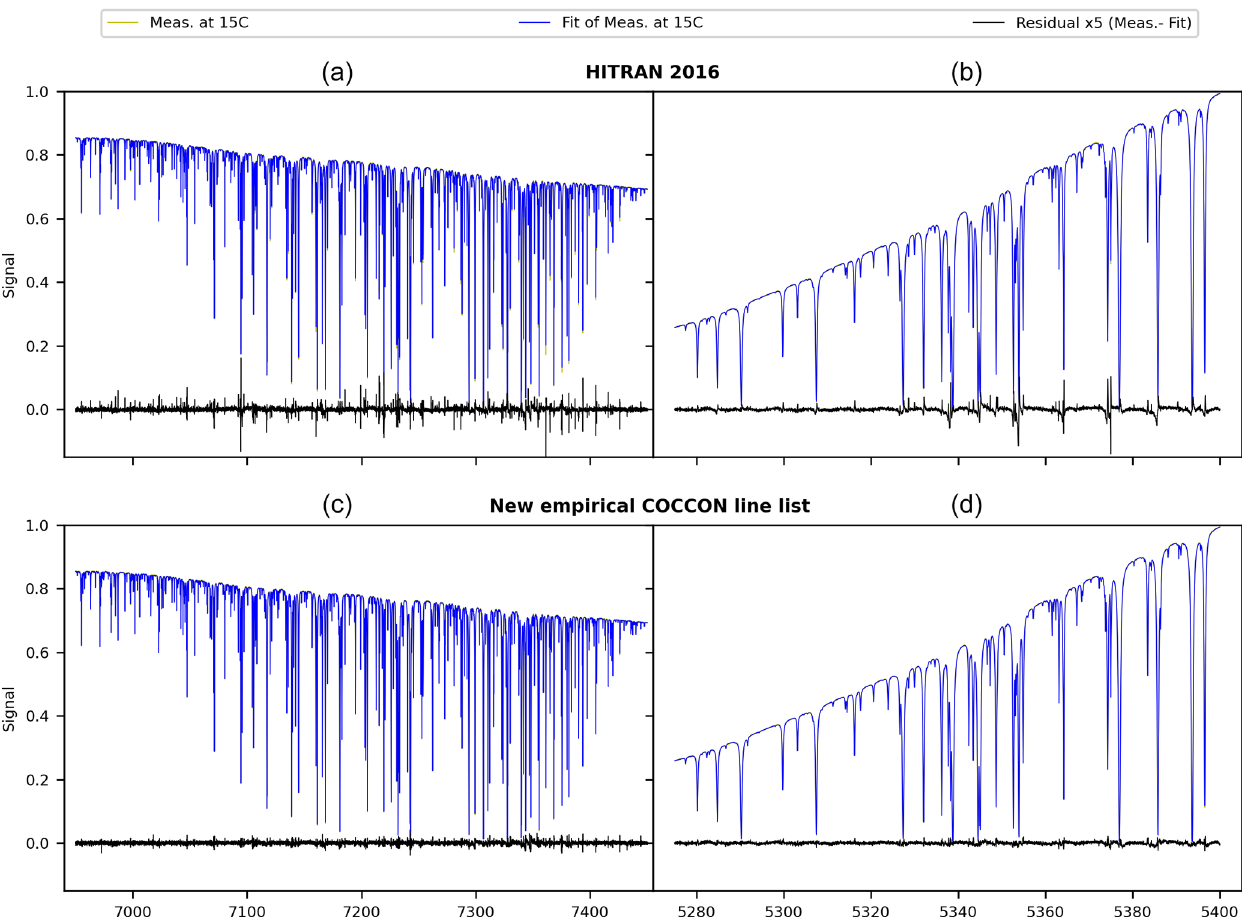
Figure A1. H 2 O spectroscopic lines used for this ILS calibration study. The fits (multi-spectrum fit performed) using HITRAN 2016 and the new empirical COCCON line list are presented in (a, b) and (c, d) , respectively. The measured spectra were taken with the IFS125HR at KIT Karlsruhe, at 15 ◦ C. The spectral residuals shown are multiplied by 5 in order to be